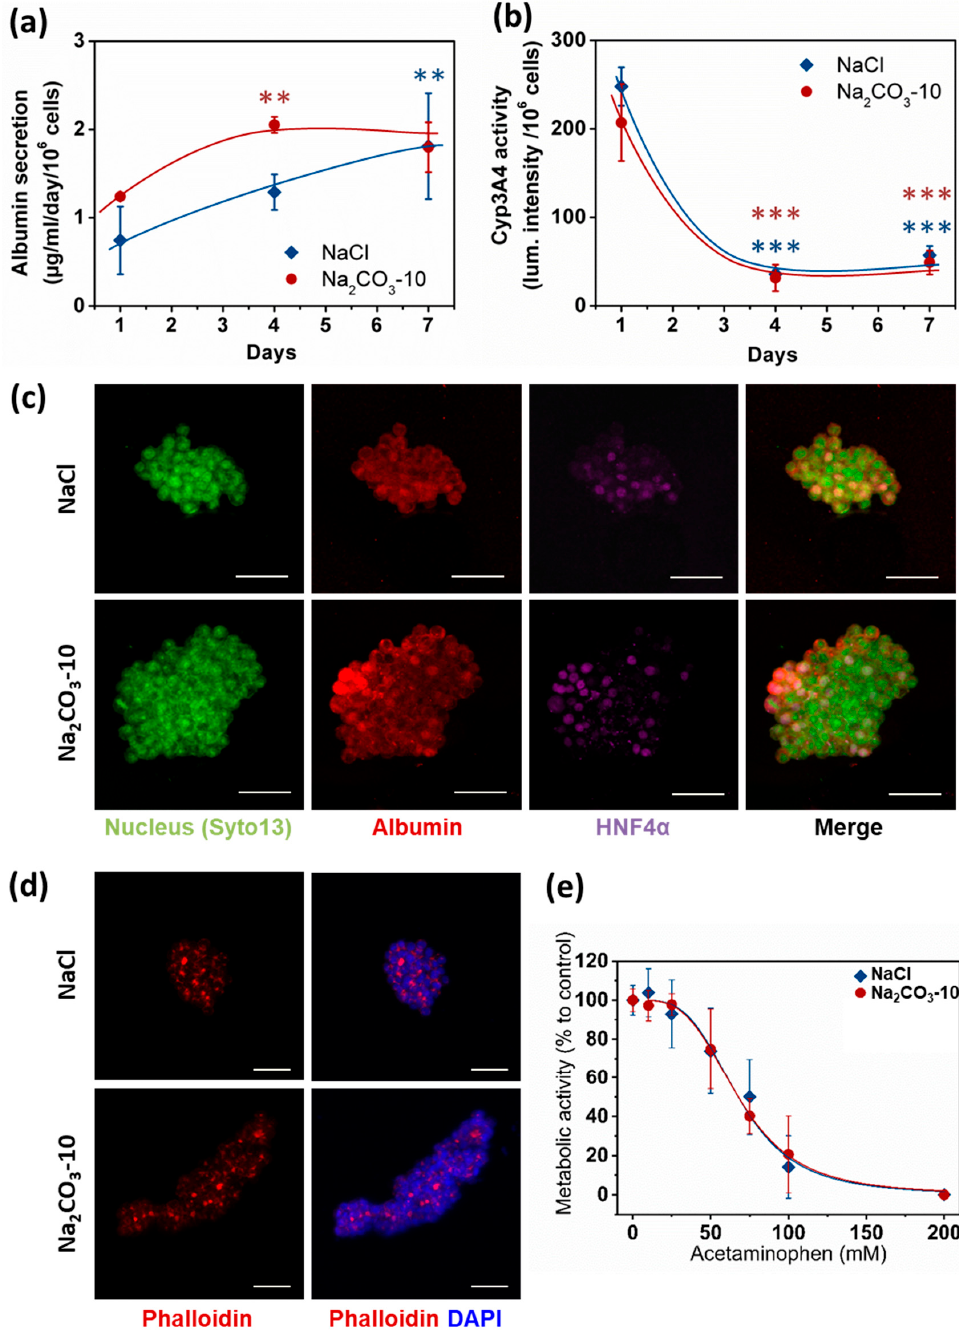
Figure 5. HepG2 cell functionality in 3D within NaCl and Na 2 CO 3 -10 sca ff olds. ( a ) Quantification of albumin secretion in the medium for 24 h after one, four and seven days using ELISA. ( b ) Quantification of P450 cytochrome CYP3A4 activity overtime. ( c ) Confocal images (Maximum intensity projection) of typical cell clusters showing the expression of Albumin (red) in the cytoplasm and HNF4 α (purple) localized in the nucleus for sca ff olds prepared with NaCl (top panel, 30 µ m total thickness) and Na 2 CO 3 -10 (bottom panel, 80 µ m total thickness) at day seven. ( d ) Confocal images at day seven (Maximum intensity projection) of typical cell clusters showing the aggregation of Actin (red) in between cells for sca ff olds prepared with NaCl (top panel, 49 µ m total thickness) and Na 2 CO 3 -10 (bottom panel, 94 µ m total thickness). ( e ) Acetaminophen-induced toxicity at day seven on HepG2 cells after 24 h treatment in NaCl and Na 2 CO 3 -10 sca ff olds. Scale bars: 50 µ m. Statistical analysis was performed using ANOVA with Tukey’s post-test. ** p < 0.01, *** p <